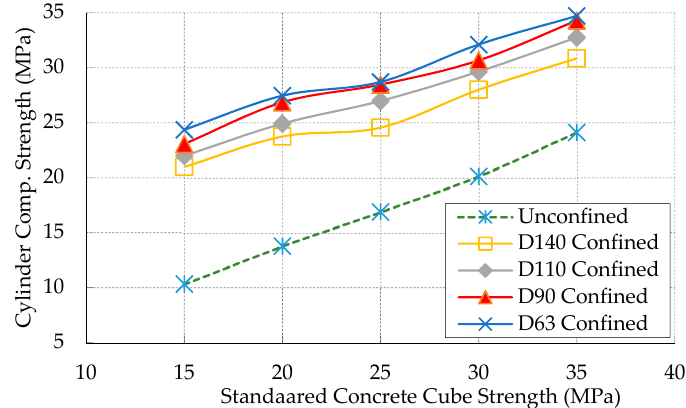
Figure 12. Effect of concrete classes on the strength of uPVC confined concrete cylinders.